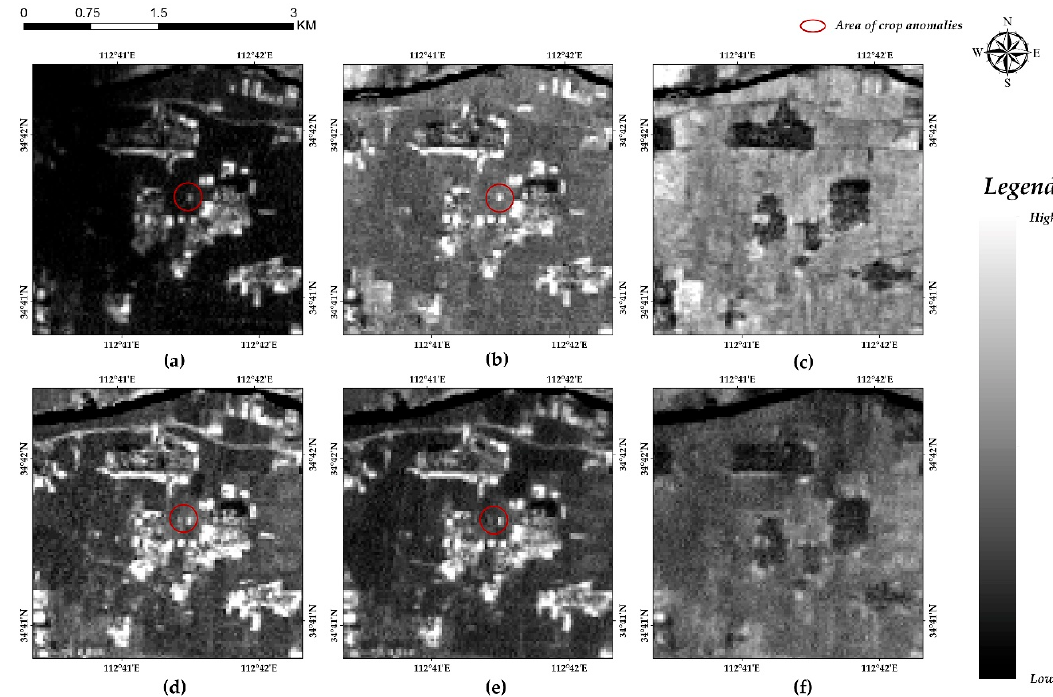
Figure 11. NDVI image series of the three-leaf stage of winter wheat planting period in 1999 and 2000 at the Erlitou site. Year 1999: ( a ) Emergence (28 October 1999); ( b ) Three-leaf (12 November 1999); ( c ) Tillering (28 November 1999). Year 2000: ( d ) Emergence (29 October 2000); ( e ) Emergence (30 October 2000); ( f ) Tillering (22 November 2000). The positive crop anomalies displayed in the images acquired at early stages from emergence to three-leaf, disappeared from the images acquired at the tillering stage.